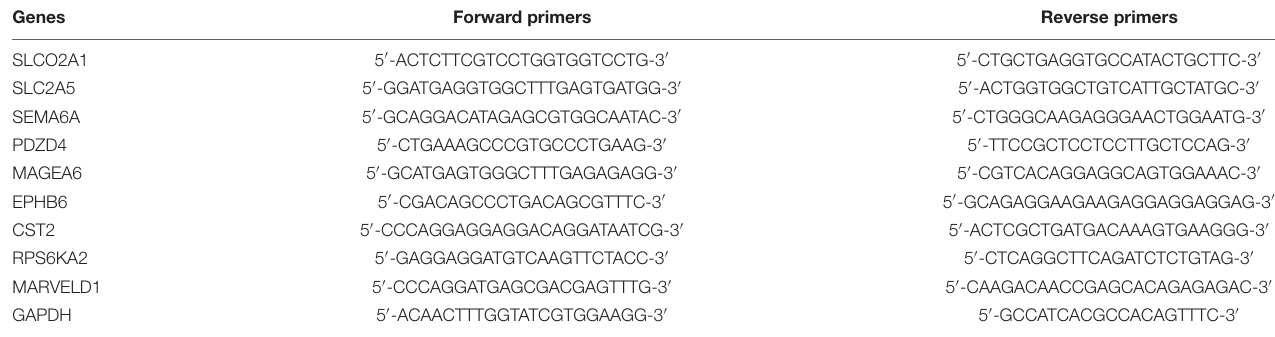
TABLE 2 | The primers of genes.